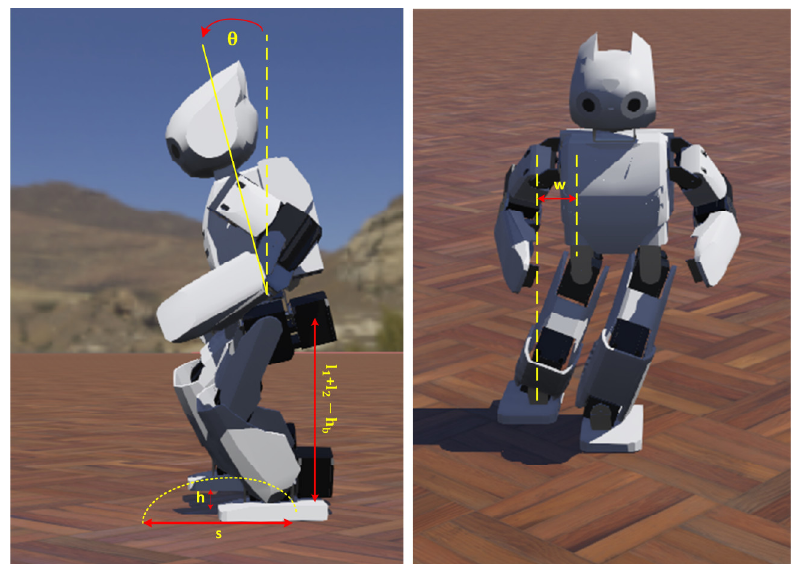
Figure 12. Representation of walking parameters.